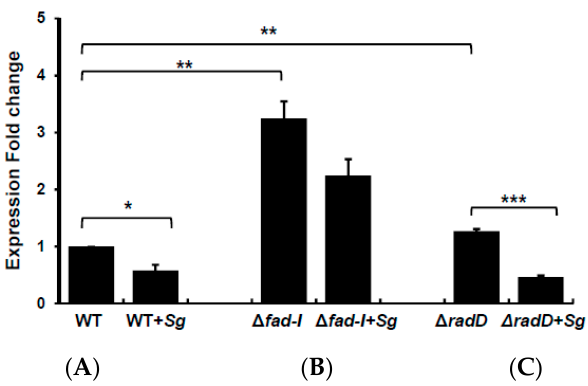
Figure 6. Transcriptional analysis of radD levels in the presence of S. gordonii . Presented are radD levels in ( A ) wild-type ATCC 23726 (WT), ( B ) Fnn_ Δ fad-I, and ( C ) Fnn _ Δ radD alone or in the presence of the partner species. Data are presented as the mean and standard error of mean of three independent experiments (* represents p ≤ 0.05, ** represents p ≤ 0.01, *** represents p ≤ 0.001).